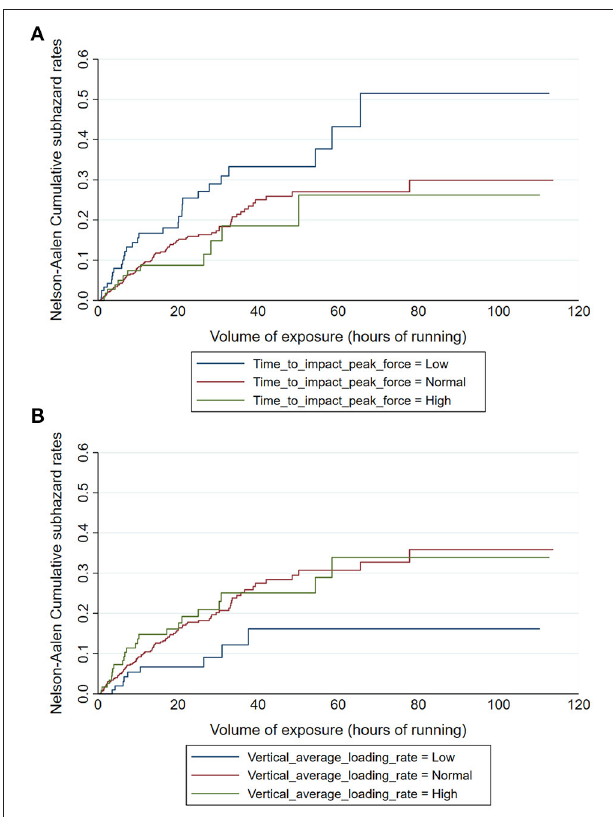
FIGURE 6 | Cumulative incidence functions for running-related injury according to time to impact peak force [ms, (A) ] and vertical average loading rate [BW.s − 1 , (B) ] of the high frequency vertical GRF signal.